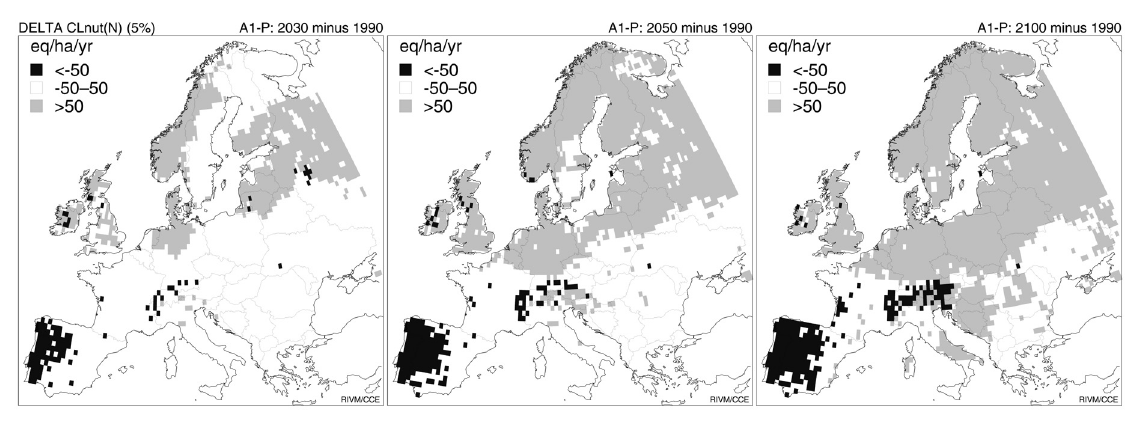
FIGURE 5. Change in the 5 th percentile of CL (N) due to climate change according to the A1-P scenario in 2030 (left), 2050 (center), and 2100 (right). nut